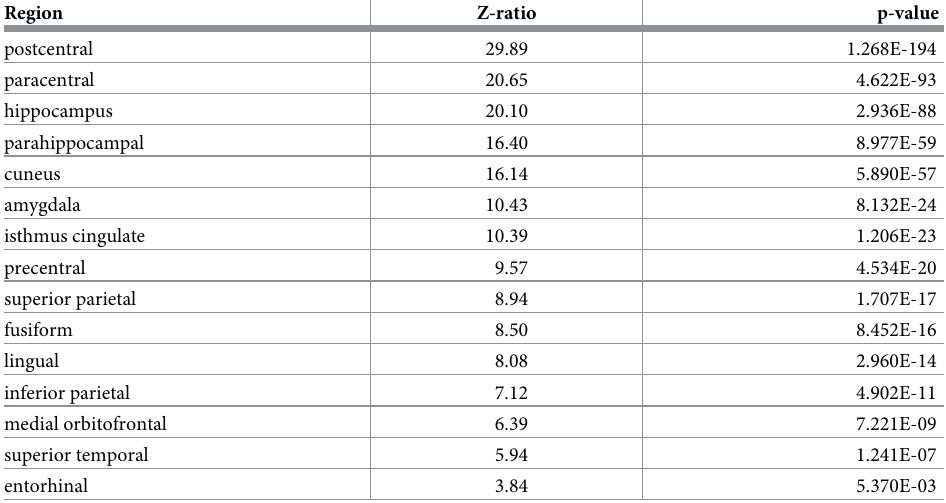
Table 5. Cortical and subcortical areas showing reliable co-activity with IC3 (correlated with Somatomotor net- work) relative to the mean co-activity value of all other areas. p-values corrected for multiple comparisons using Bonferroni